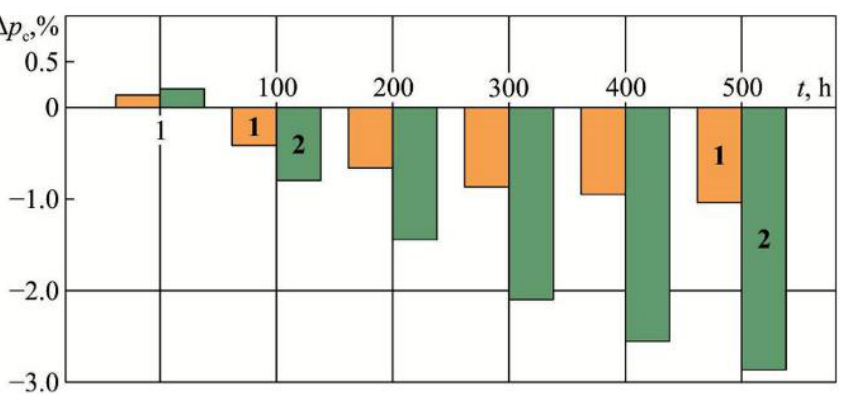
Figure 10. Relative percentage change in compression pressure, Δ р с , diesel 5L23/30 MAN-B&W Diesel Group under different experimental conditions: 1—diesel AE 1; 2—diesel AE 2.